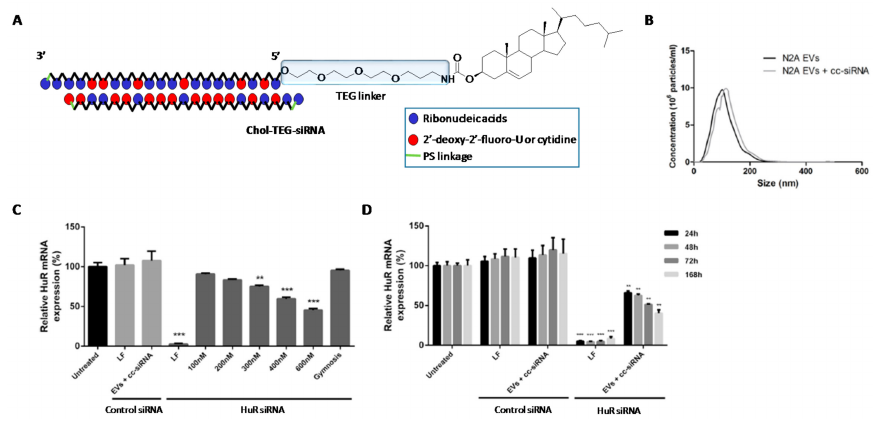
Figure 6. ( A ) Chemical structure of Chol-siRNA conjugate containing the hydrophobic residue at the 5’-termini of the siRNA passenger strand. ( B ) Dynamic light scattering (DLS) of EVs alone and in the presence of Chol-siRNA conjugate. ( C ) Dose-response at several concentrations of EVs:siRNA (100, 200, 300, 400 and 600 nM) targeting HuR mRNA expression. ( D ) Evaluation of silencing process during time (24, 48, 72 and 168 h). * represents significant values of Chol-siRNA conjugate when compared to negative controls (untreated cells). Adapted with permission from ref. [133]. Copyright 2017, The American Society of Gene and Cell